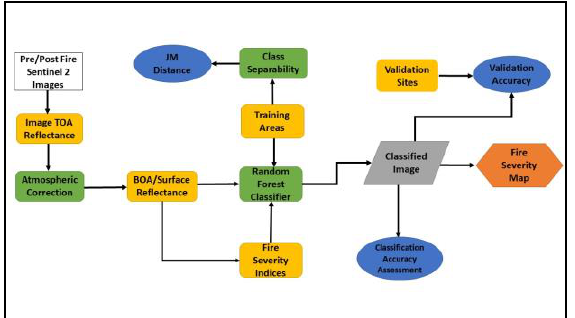
Figure 3. Flowchart of the methodology used in the